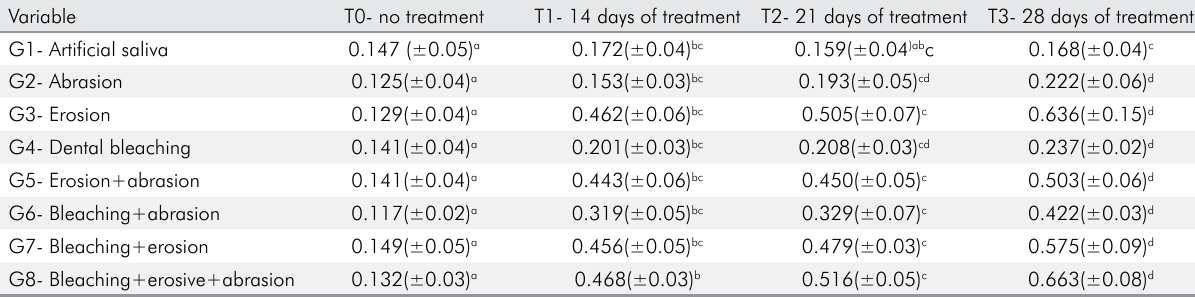
Table 2. Mean ± standard deviation for the SR analysis as a function of time for all groups. Variable